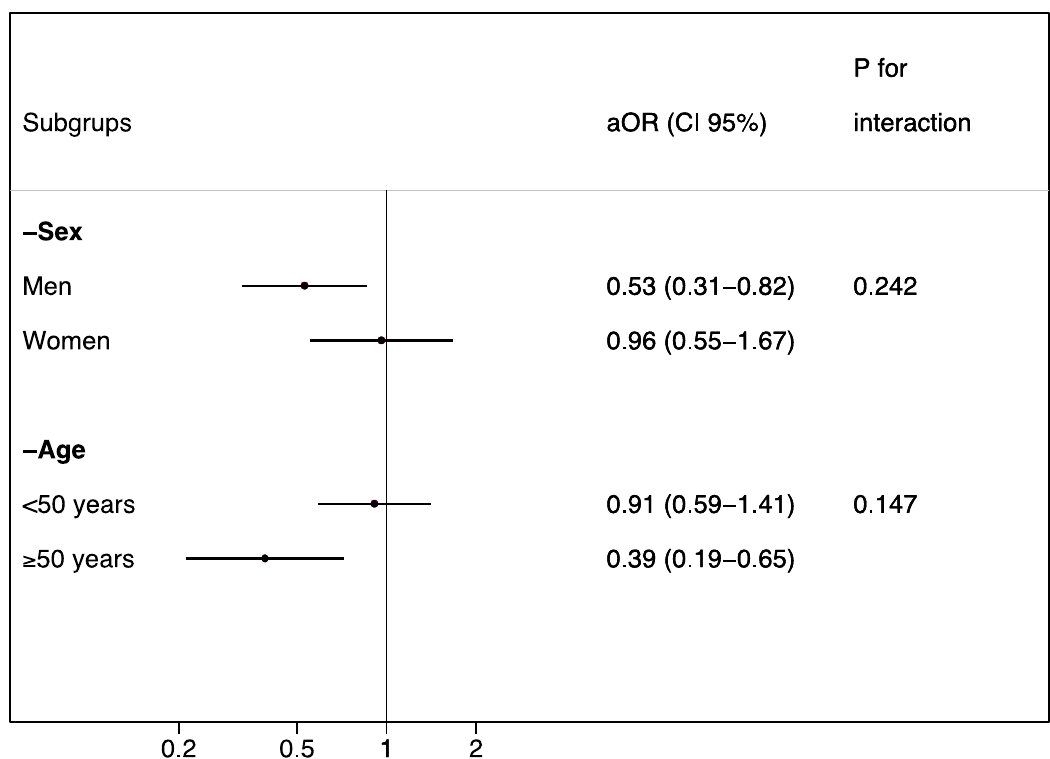
Figure 3. Risk of metabolic syndrome in the highest category compared to the lowest category of the Healthy Lifestyle Score. Stratified analyses (the SUN cohort); aOR: Adjusted odds ratio; CI: Confidence interval.